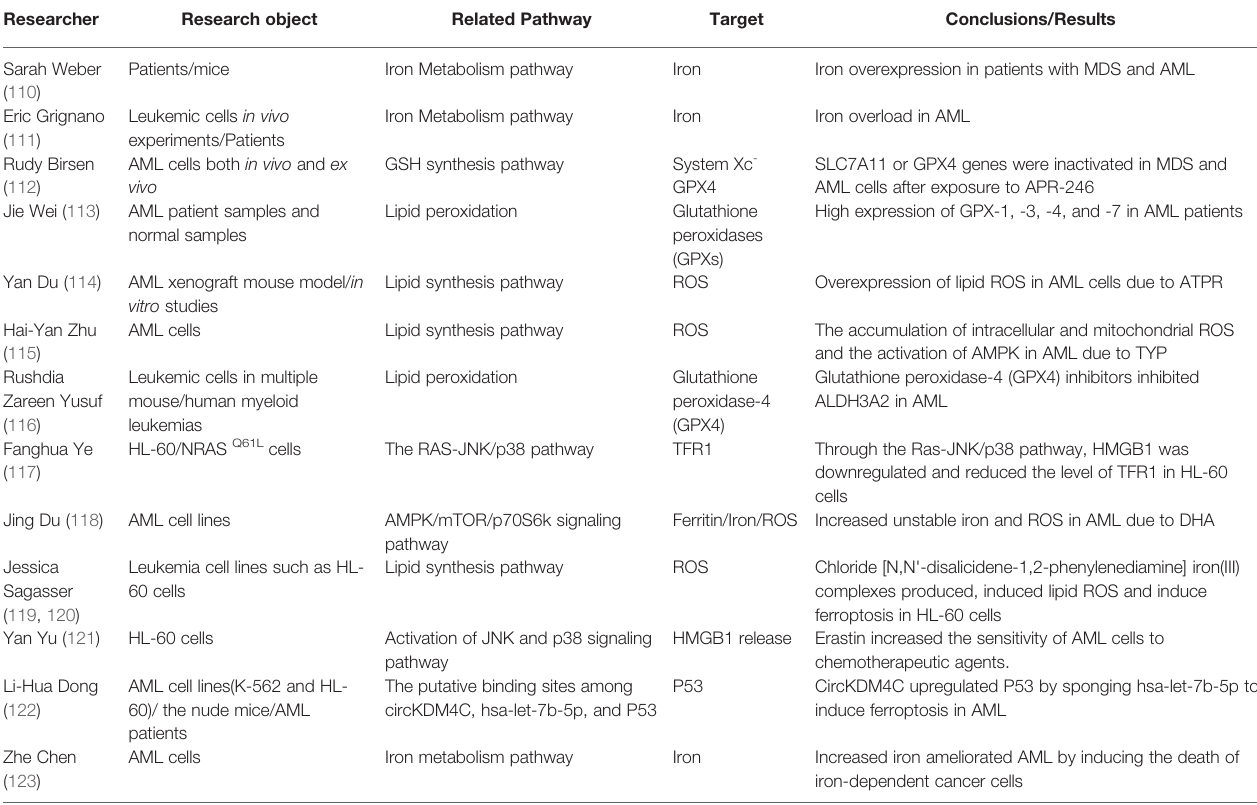
TABLE 2 | Research progress on ferroptosis in acute myeloid